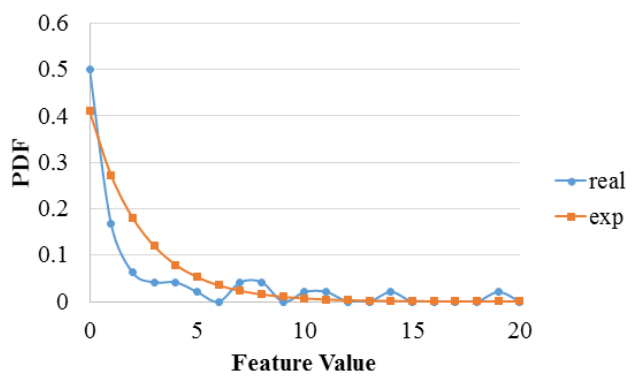
Figure 4. The PDF example of feature data distribution, Chord V.